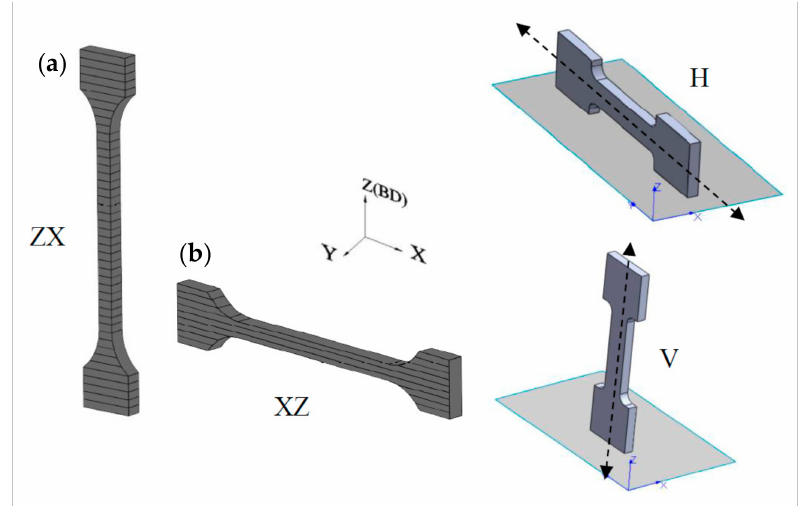
Figure 5. Tensile samples oriented in: ( a ) XZ plane and ( b ) ZX